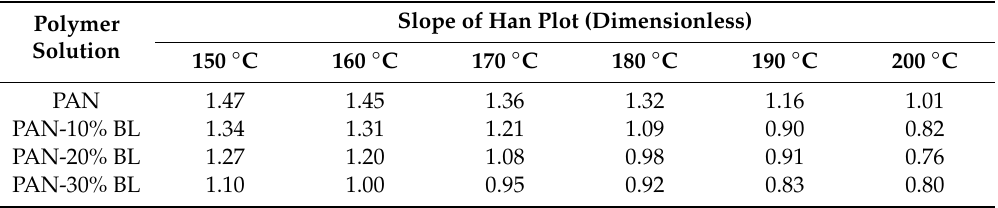
Table 2. The slope of the Han plot at di ff erent temperatures and BL blending with PAN in [BMIM]Cl. Slope of Han Plot Polymer Solution